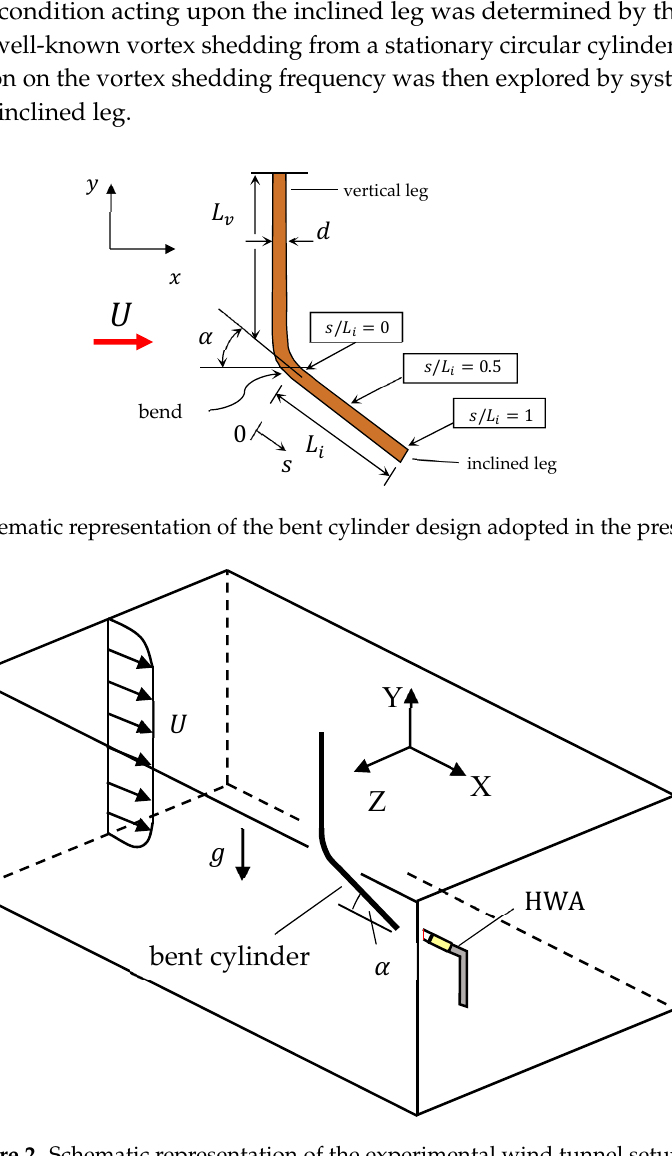
Figure 2. Schematic representation of the experimental wind tunnel setup.